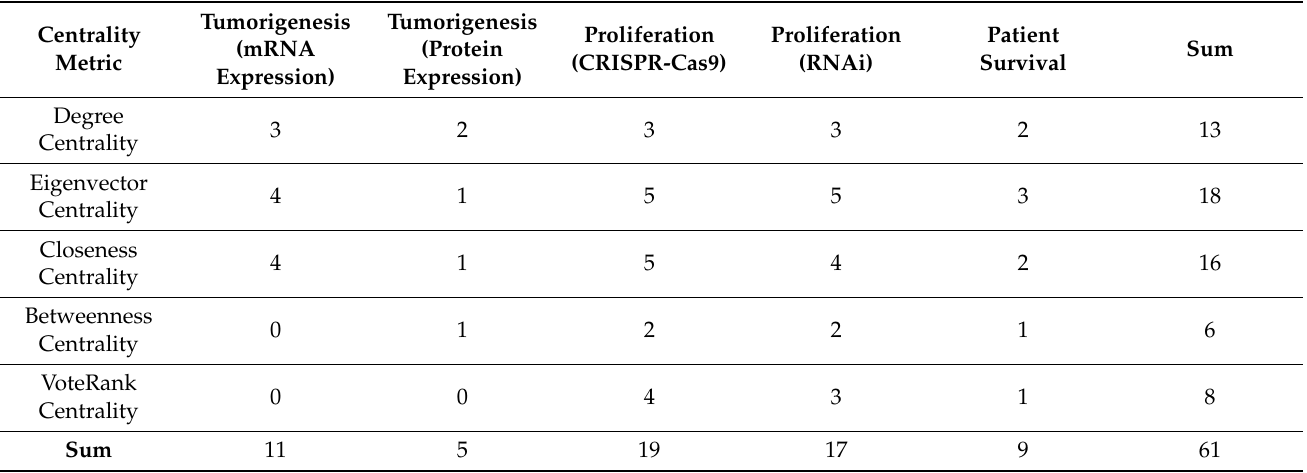
Table 4. Counts of concordant significant associations of each centrality metric with tumorigenesis, proliferation, and patient survival in the multi-omics